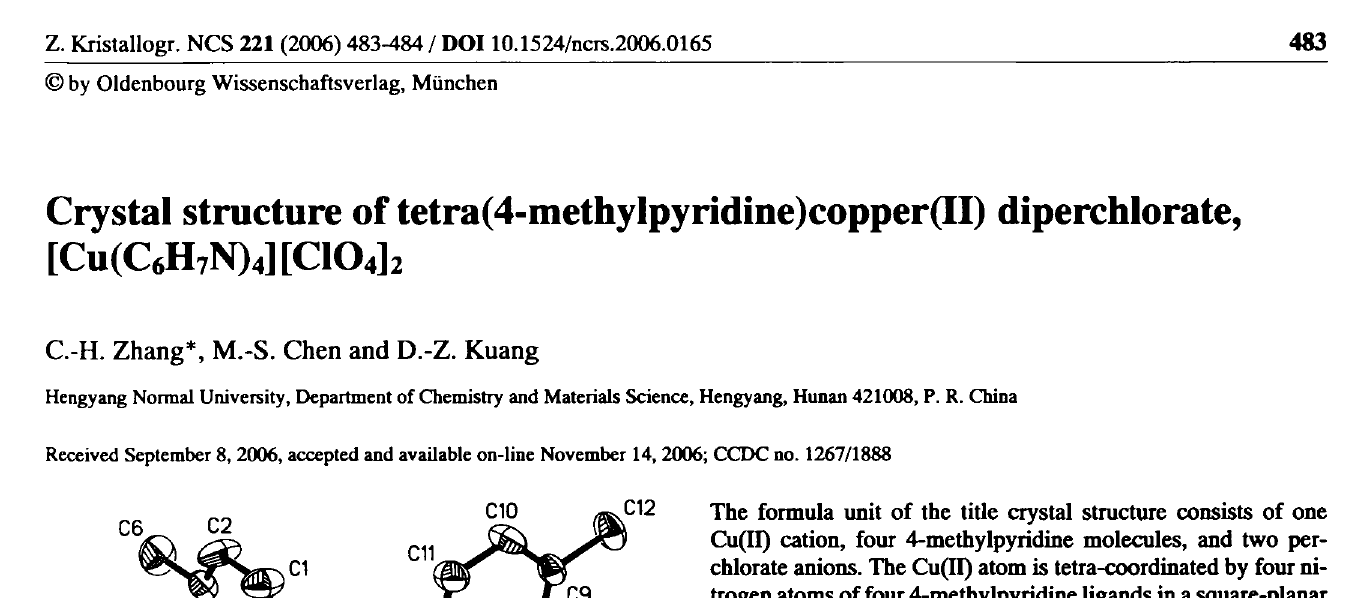
Table 1. Data collection and handling.